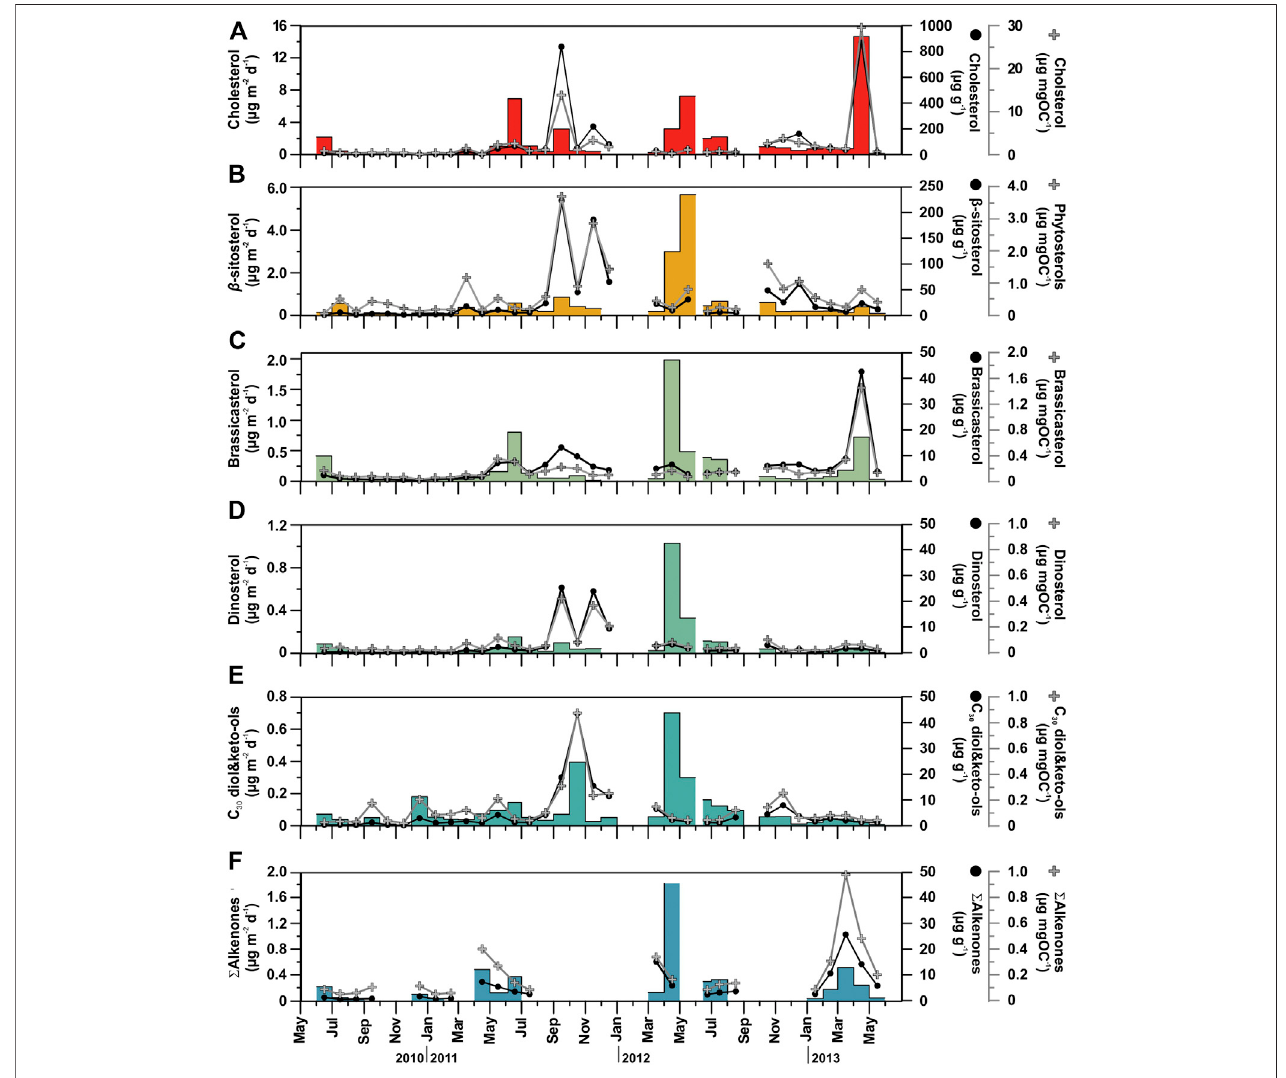
FIGURE 6 | Temporal distribution patterns ( fl uxes and concentrations) of major phytoplankton- and zooplankton-derived POC compounds (marine origin) in sinking particulate matter collected at 4,285 m in the Ierapetra Basin during the studied period (see section “ Oceanographic and Atmospheric Settings ” . for further